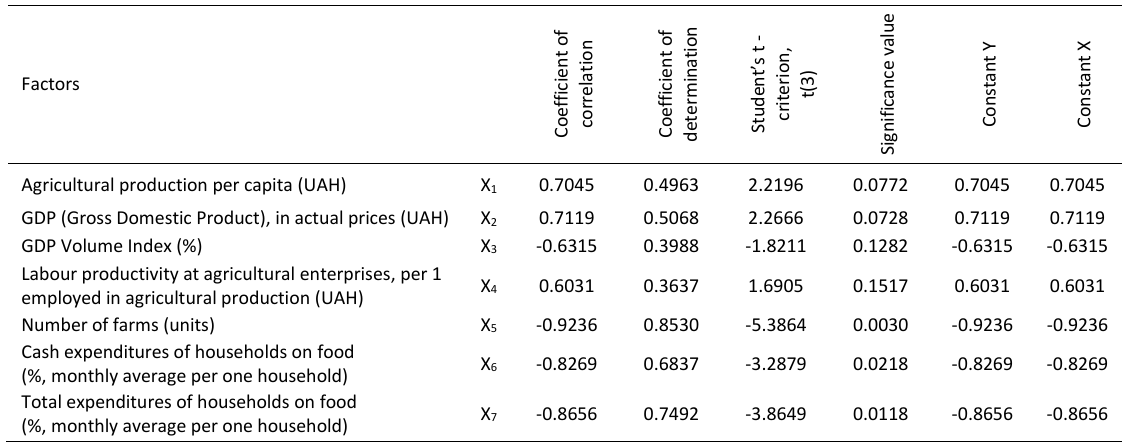
Table 7: Research of connection between the crop production volumes and economic factors in Ukraine (correlation analysis) (State Statistics Service of Ukraine, 2018b; State Statistics Service of Ukraine, 2018f; State Statistics Service of Ukraine, 2018c; State Statistics